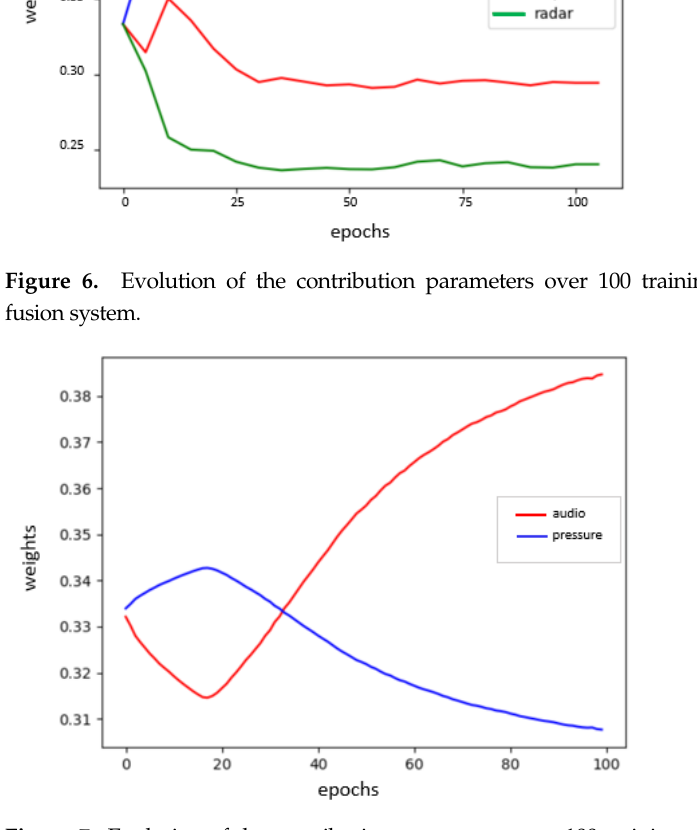
Figure 7. Evolution of the contribution parameters over 100 training epochs for the audio/pressure fusion